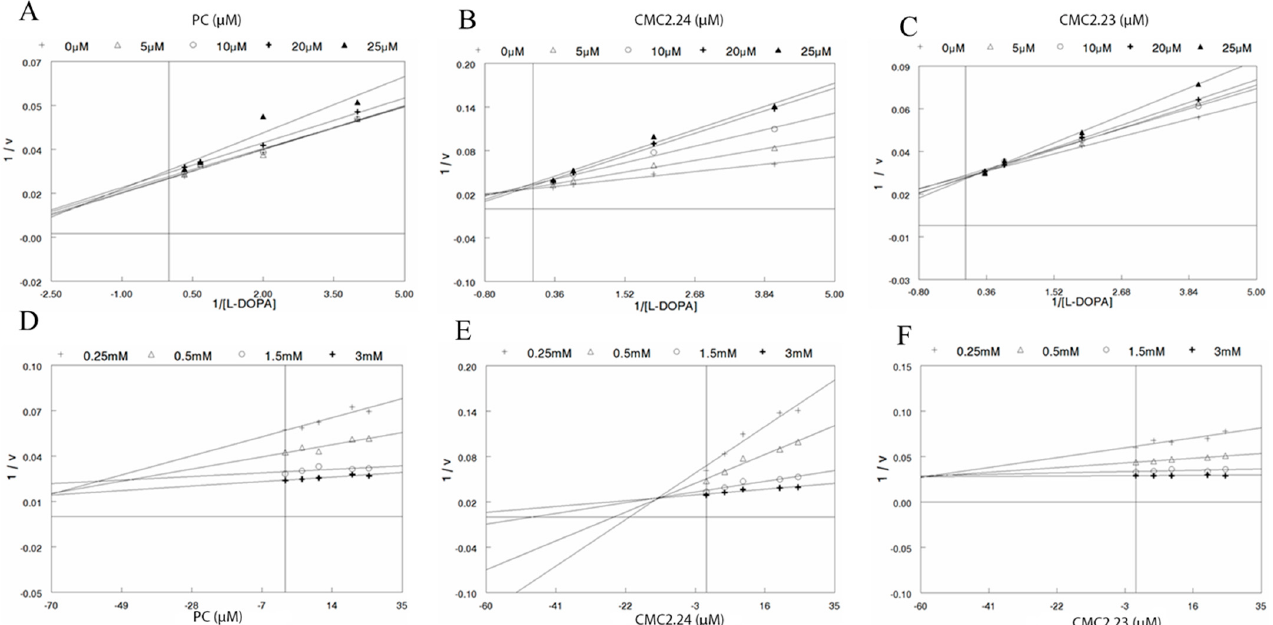
Figure 3. Kinetic analysis of diphenolase inhibition by PC, CMC2.24 and CMC2.23. Lineweaver-Burk plots showing the reciprocal of velocity (1/v) of tyrosinase reaction vs. reciprocal of substrate (1/ L -DOPA) for ( A ) PC; ( B ) CMC2.23 and; ( C ) CMC2.23; Dixon plots for the inhibition of diphenolase activity of mushroom tyrosinase by ( D ) PC; ( E ) CMC2.24 and; ( F ) CMC2.23 in presence different concentrations of L -DOPA substrate (0.25, 0.5, 1.5 and 3 mM).